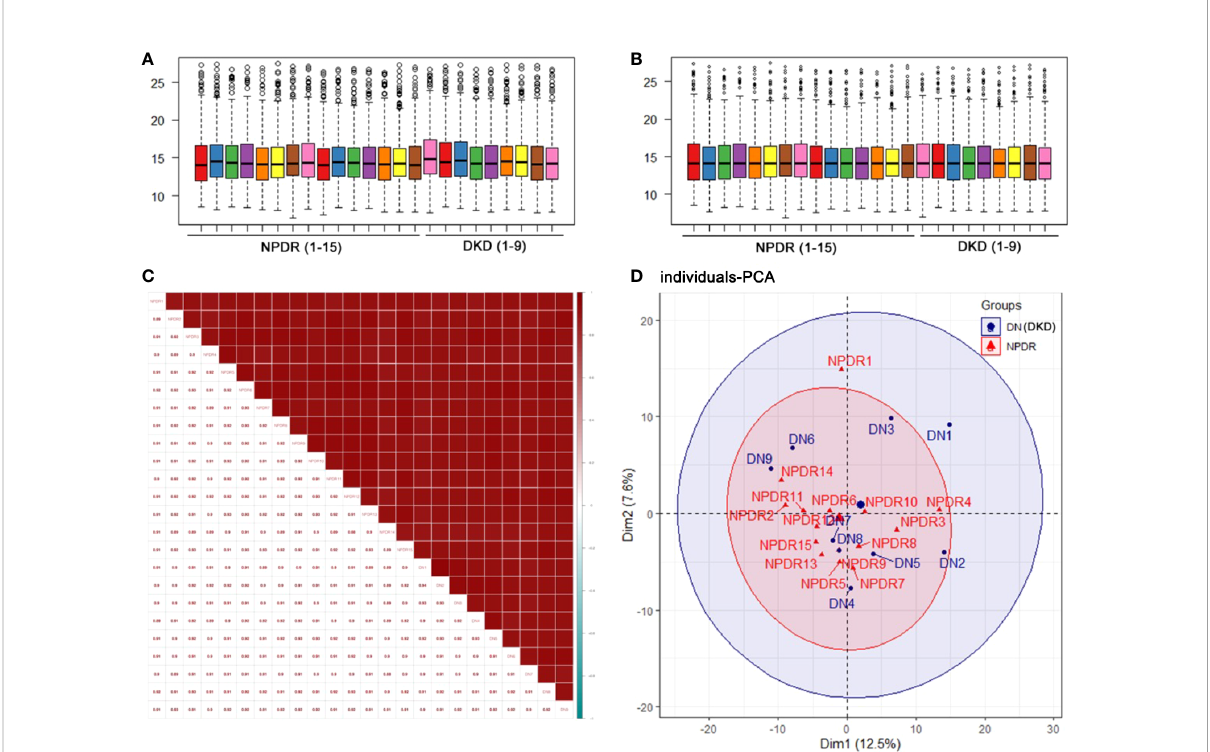
FIGURE 1 Quality control of the proteomic analysis. (A) Median correction before normalization. (B) Median correction after normalization. (C) Pearson correlation coef fi cients represent the correlation between samples. A higher correlation and a deeper red color indicate better repeatability of the data. The color bar from red to blue represents correlations from high to low. (D) Principal component analysis (PCA) illustrates partial overlap among the NPDR and NPDR+DKD (DKD)